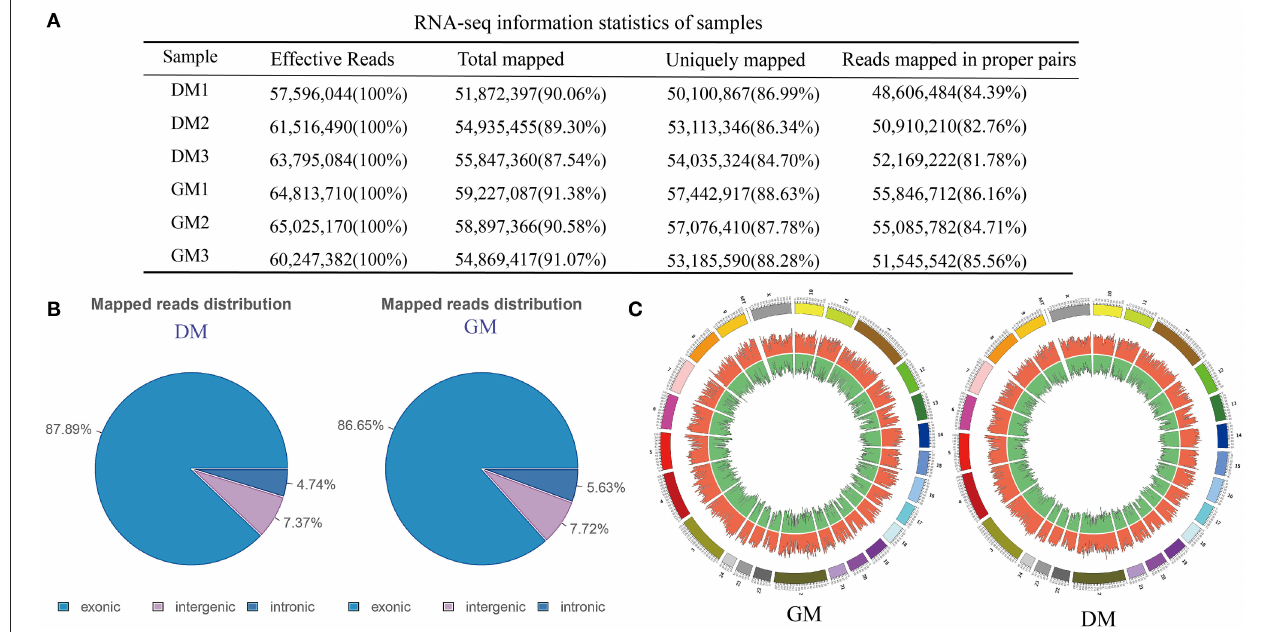
FIGURE 2 | RNA-seq analysis of buffalo MuSCs during proliferation and differentiation. (A) RNA-seq information statistics of samples. (B) Mapped reads distribution. (C) The distribution for the reads in different chromosomes.